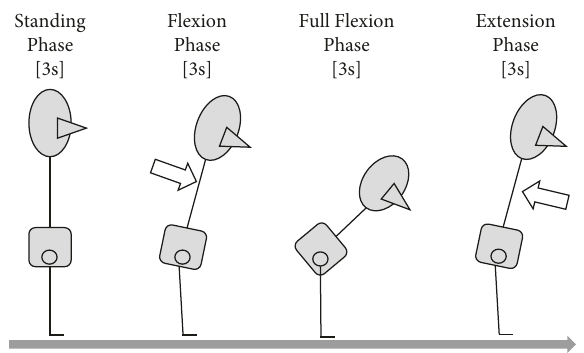
Figure 1: The lumbar bending and returning